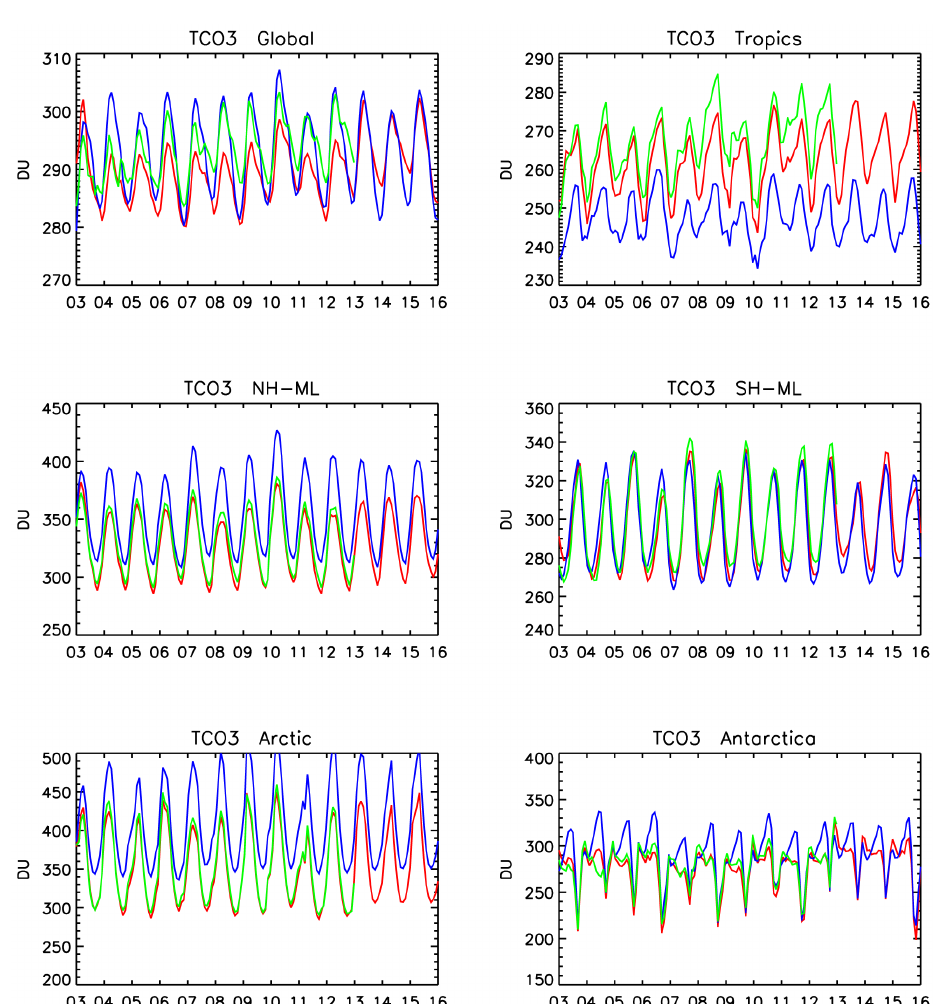
Figure 15. Monthly ozone TC (DU) area averaged over different regions (see Table 3) from CAMSiRA (black), the CR (blue) and MACCRA (green) for